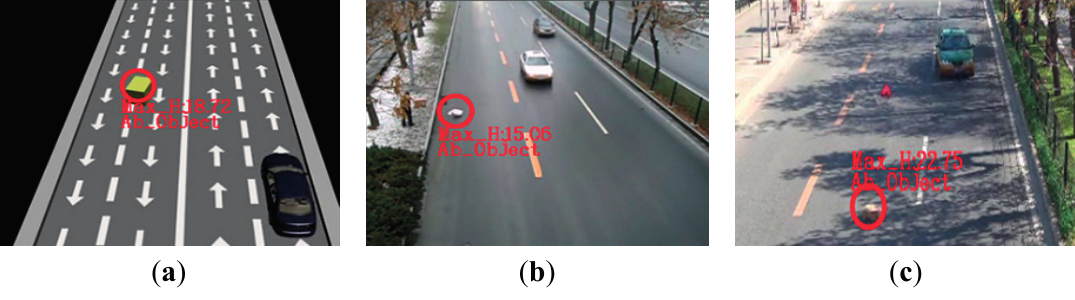
Figure 14. Abandoned object detection for different scenarios. ( a ) detection result in simulations situation; ( b , c ) detection results in real road experiments situation.